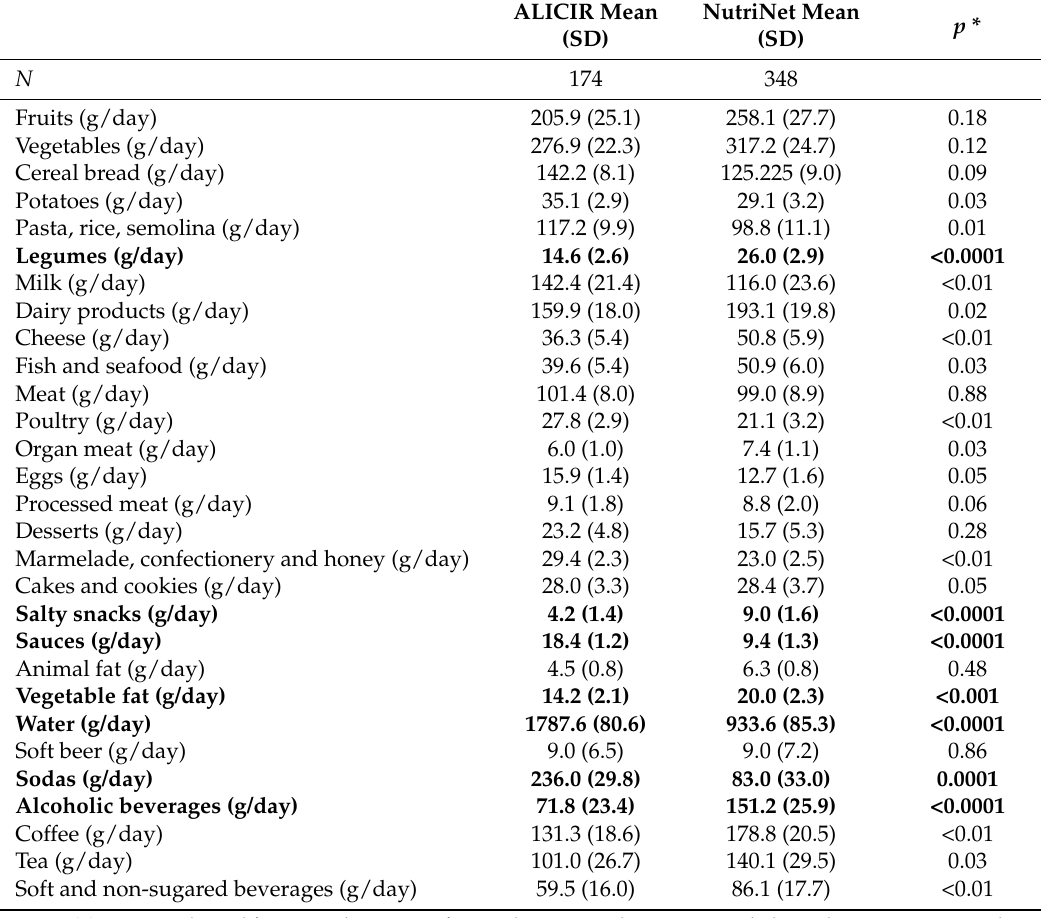
Table 3. Comparison of adjusted dietary intakes between controls and cases ( N =